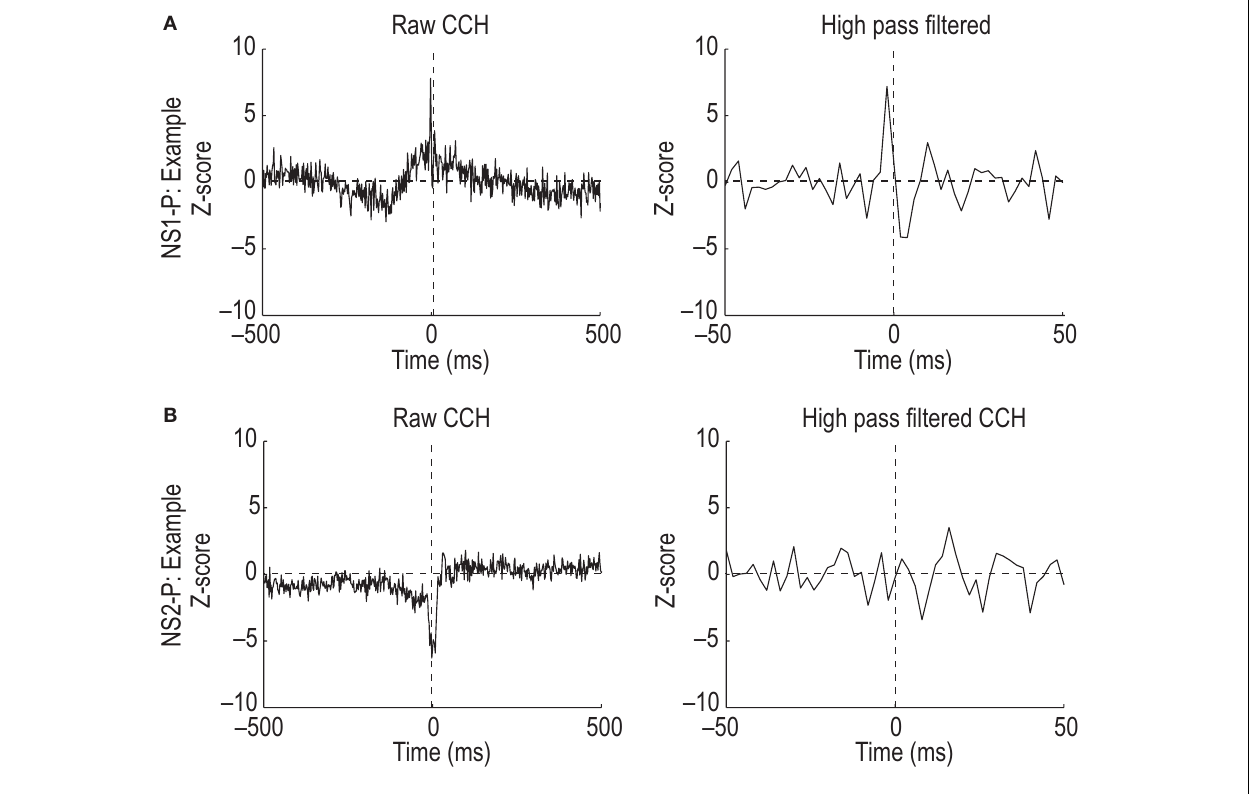
FIGURE 4 | Cell-type specifi c local network interactions. (A) Representative cross-correlation histogram (left) for a single NS1–WS cell pair. Firing probability of wide-spiking cell, measured as number of standard deviations from baseline, is plotted relative to the occurrence of spikes from the NS1 neuron. High pass fi ltering of the raw CCH (right) reveals a signifi cant increase in the fi ring